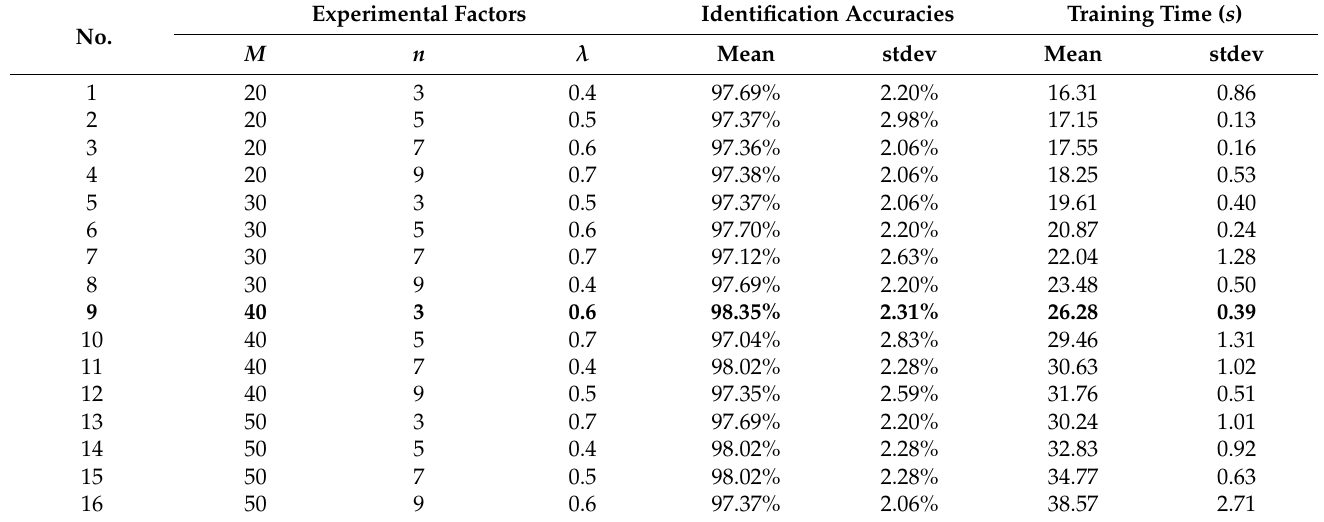
Table 1. Orthogonal experimental results of utilizing different values for M , n , and λ in LwCNN.